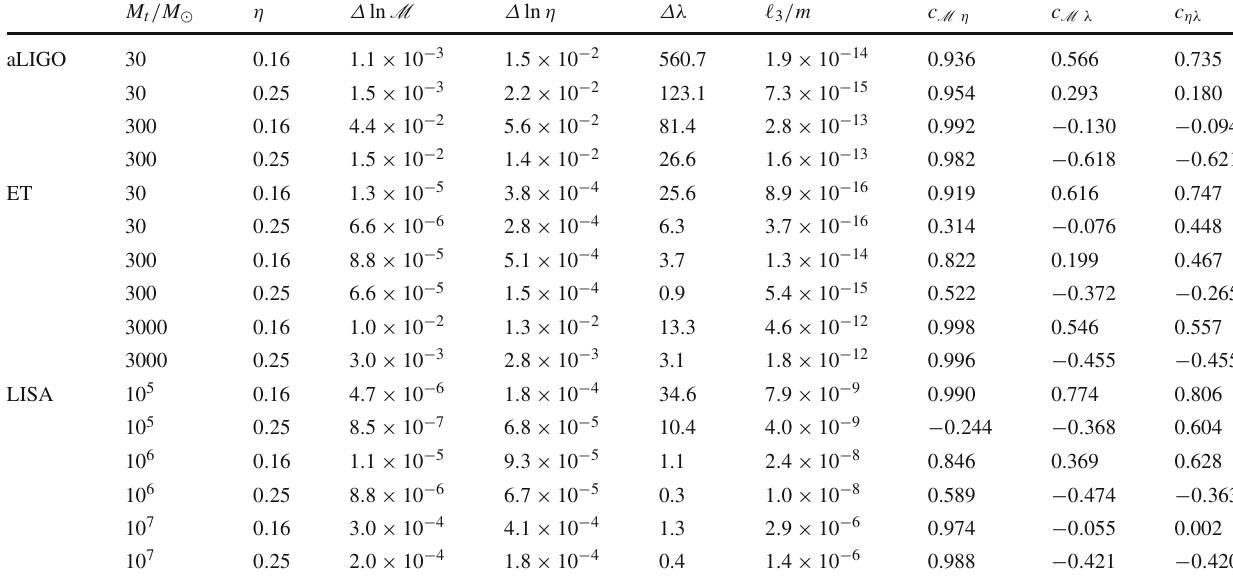
Table 1 In the case of α = 3, for different value of η , the rms uncertainties on ln M , ln η and λ , as well as their cross correlations. The uncertainties on (cid:4) 3 are also listed